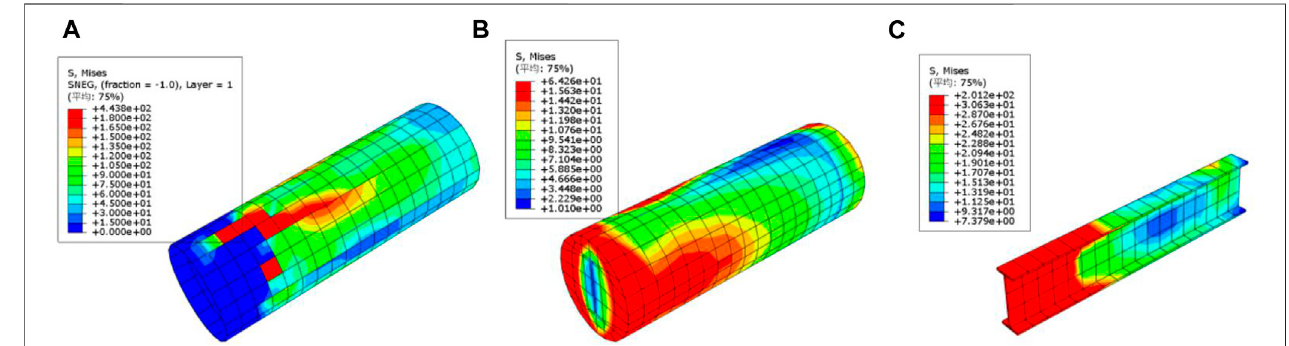
FIGURE 9 | The stress distribution of specimen GRS-1: (A) GFRP; (B) RPC; and (C) steel.